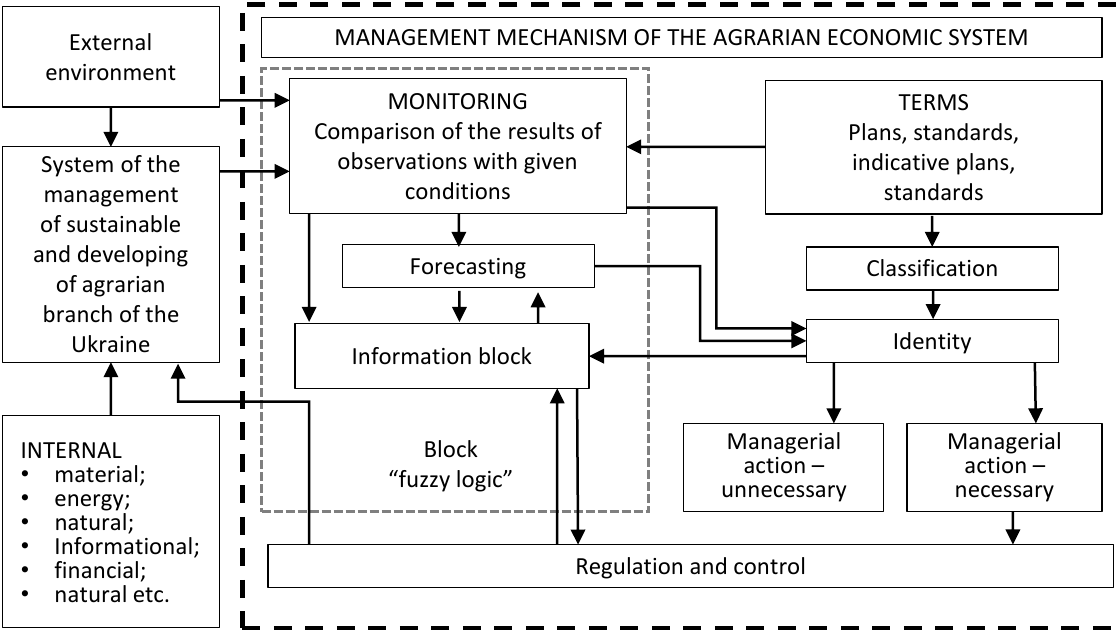
Figure 7. The structural diagram of the management mechanism of the agrarian economic